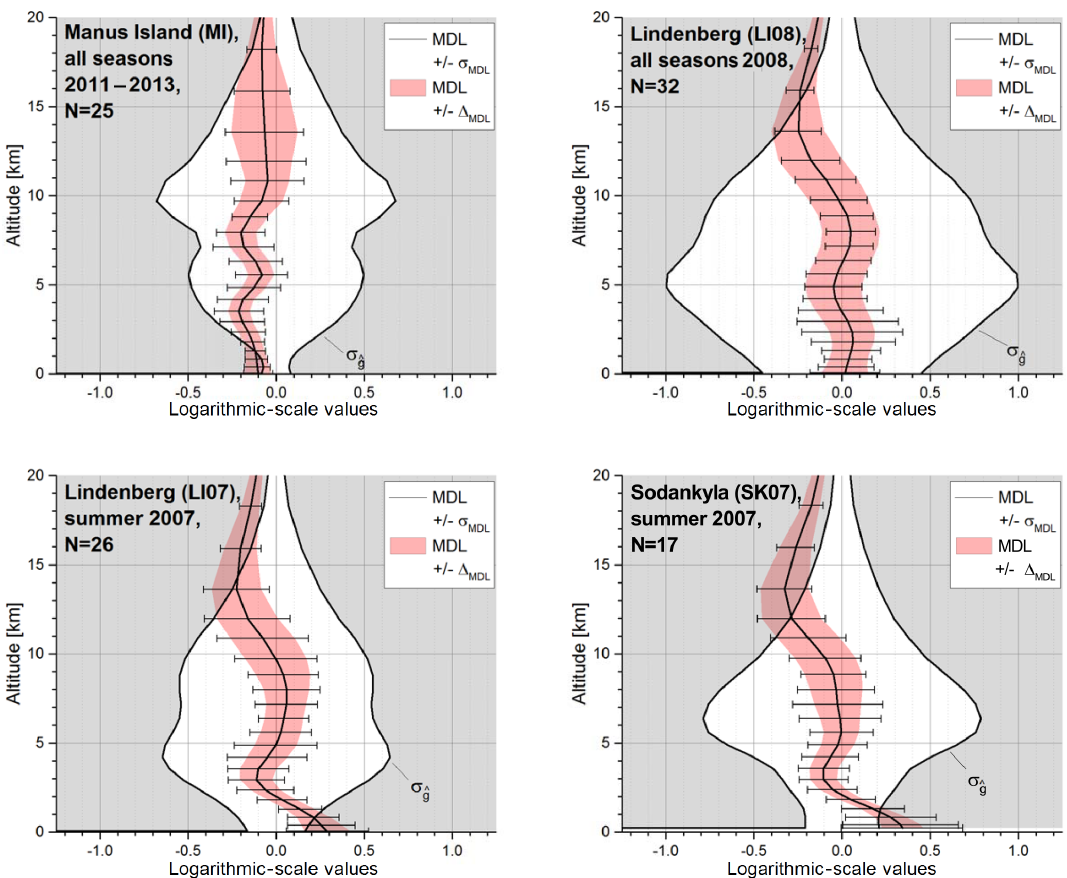
Figure 12. Same as Fig. 11, but for MUSICA IASI retrievals that use the GRUAN temperature profiles as the a priori atmospheric tempera- tures and all four ensembles (MI, LI08, LI07, and SO).